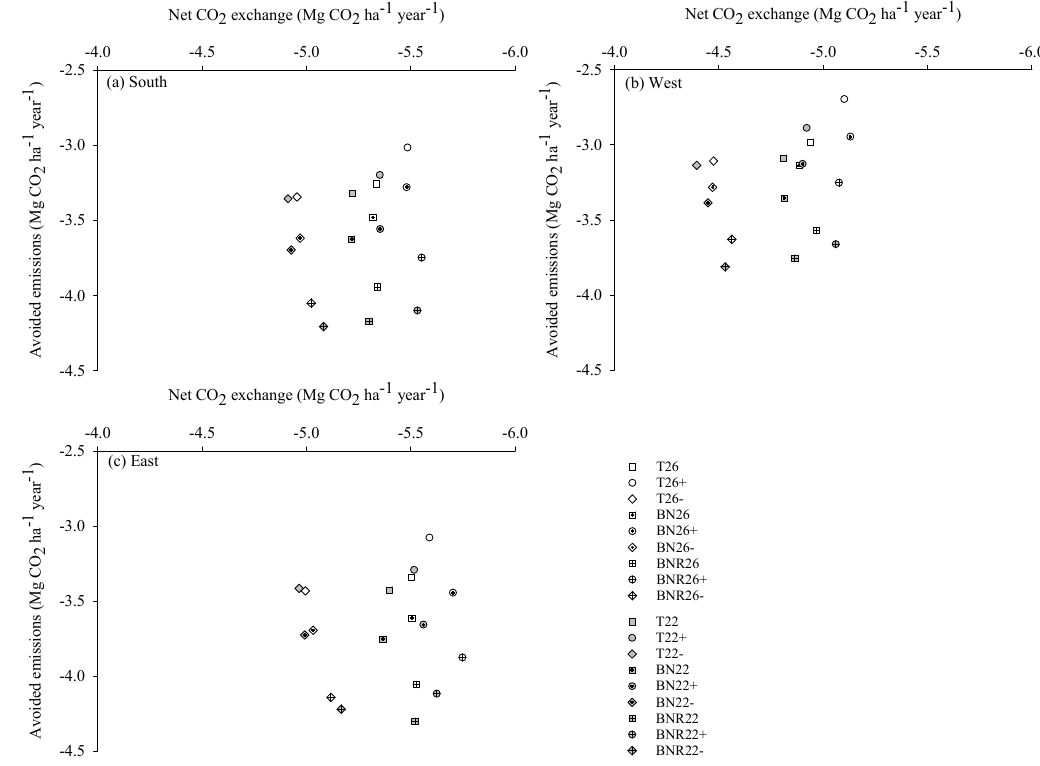
Figure 2. Annual avoided emissions (Mg CO 2 ha − 1 year − 1 ) and annual net CO 2 exchange (Mg CO 2 ha − 1 year − 1 ) over the 40-year period for different management scenarios and three different harvest intensities including timber (T), timber and logging residues, without (BN) and with coarse roots and stumps (BNR) in the final felling made at DBH of 26 cm and 22 cm in southern ( a ), western ( b ) and eastern ( c ) sub-regions of Finland. For the key of the management scenarios, see Table 1.